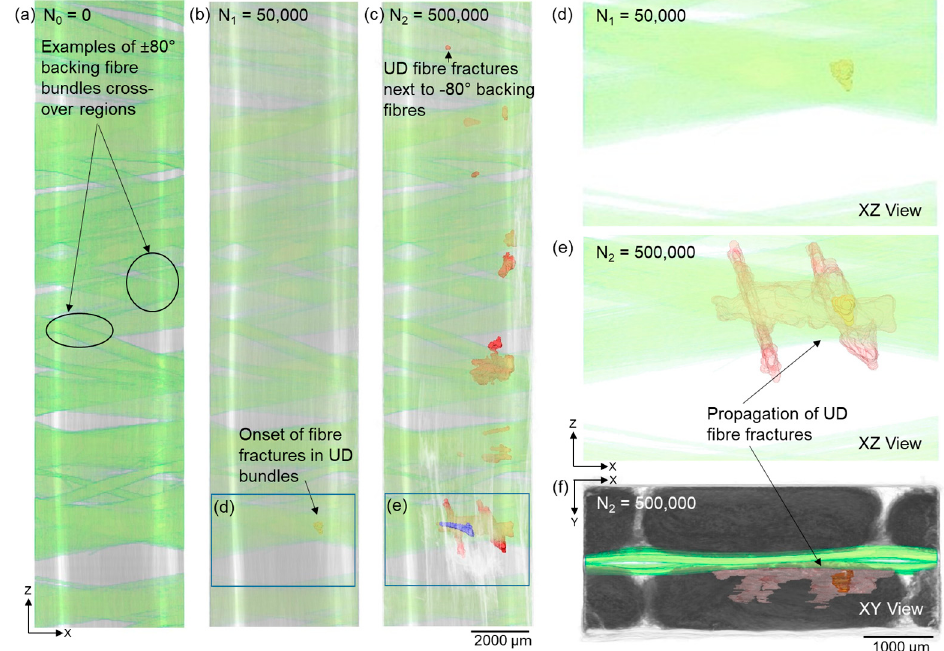
Figure 6. X-ray CT volume rendering of the backing fibre bundles ( a ) after 0 cycles showing the cross-over of the ±80° backing fibre bundles, as well as UD fibre fractures next to backing fibre bundles after ( b ) 50,000 and ( c ) 500,000 cycles, together with magnified views in ( d , e ) and in ( f ) the evolution and distribution of UD fibre fractures initiated from backing bundles after 500,000 cycles (refer to Figure 3 for explanations of colour coding). For 3D visualisation see the supplementary video.